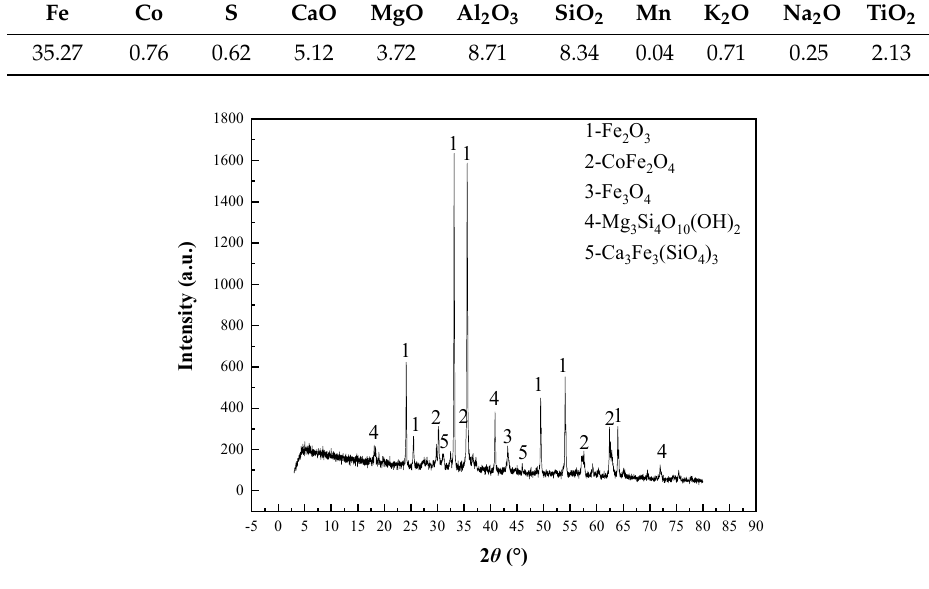
Figure 6. XRD diffractogram of oxidizing roasting ores.